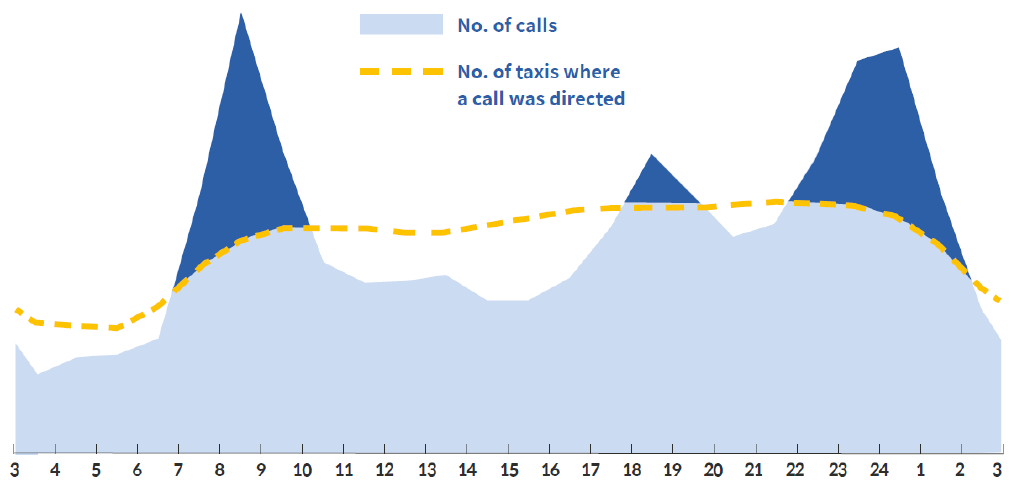
Figure 2. Time-based taxi supply and demand in the Seoul metropolitan area in 2018